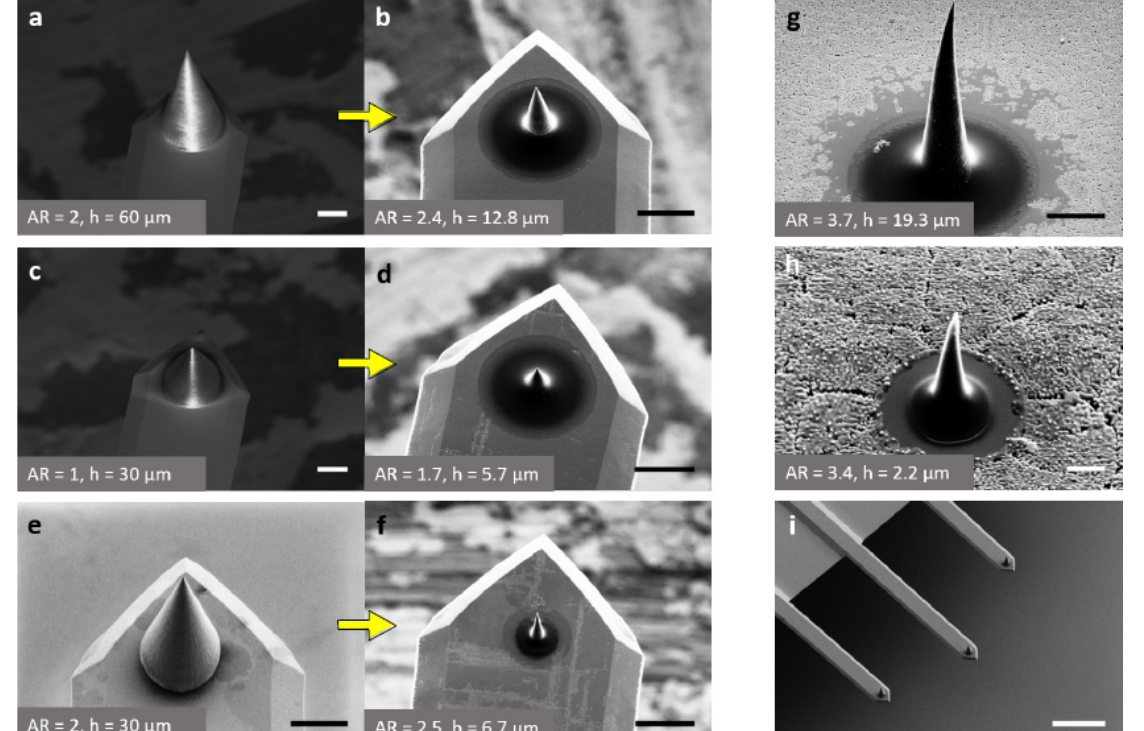
Figure 1. ( a – d ) SEM images of IP-Dip tips; and ( e , f ) IP-L tip before and after carbonization (indicated by the left-to-right arrows). Examples of ( g ) high aspect ratio; and ( h ) ultra-small carbon tips fabricated on silicon wafers; ( i ) Typical glassy carbon tips fabricated on a chip with three (previously) tip-less cantilevers. The aspect ratio and height h of each tip is given at the lower left of the SEM images. Scale bars: ( a – g ) 10µm; ( h ) 1µm; ( i )